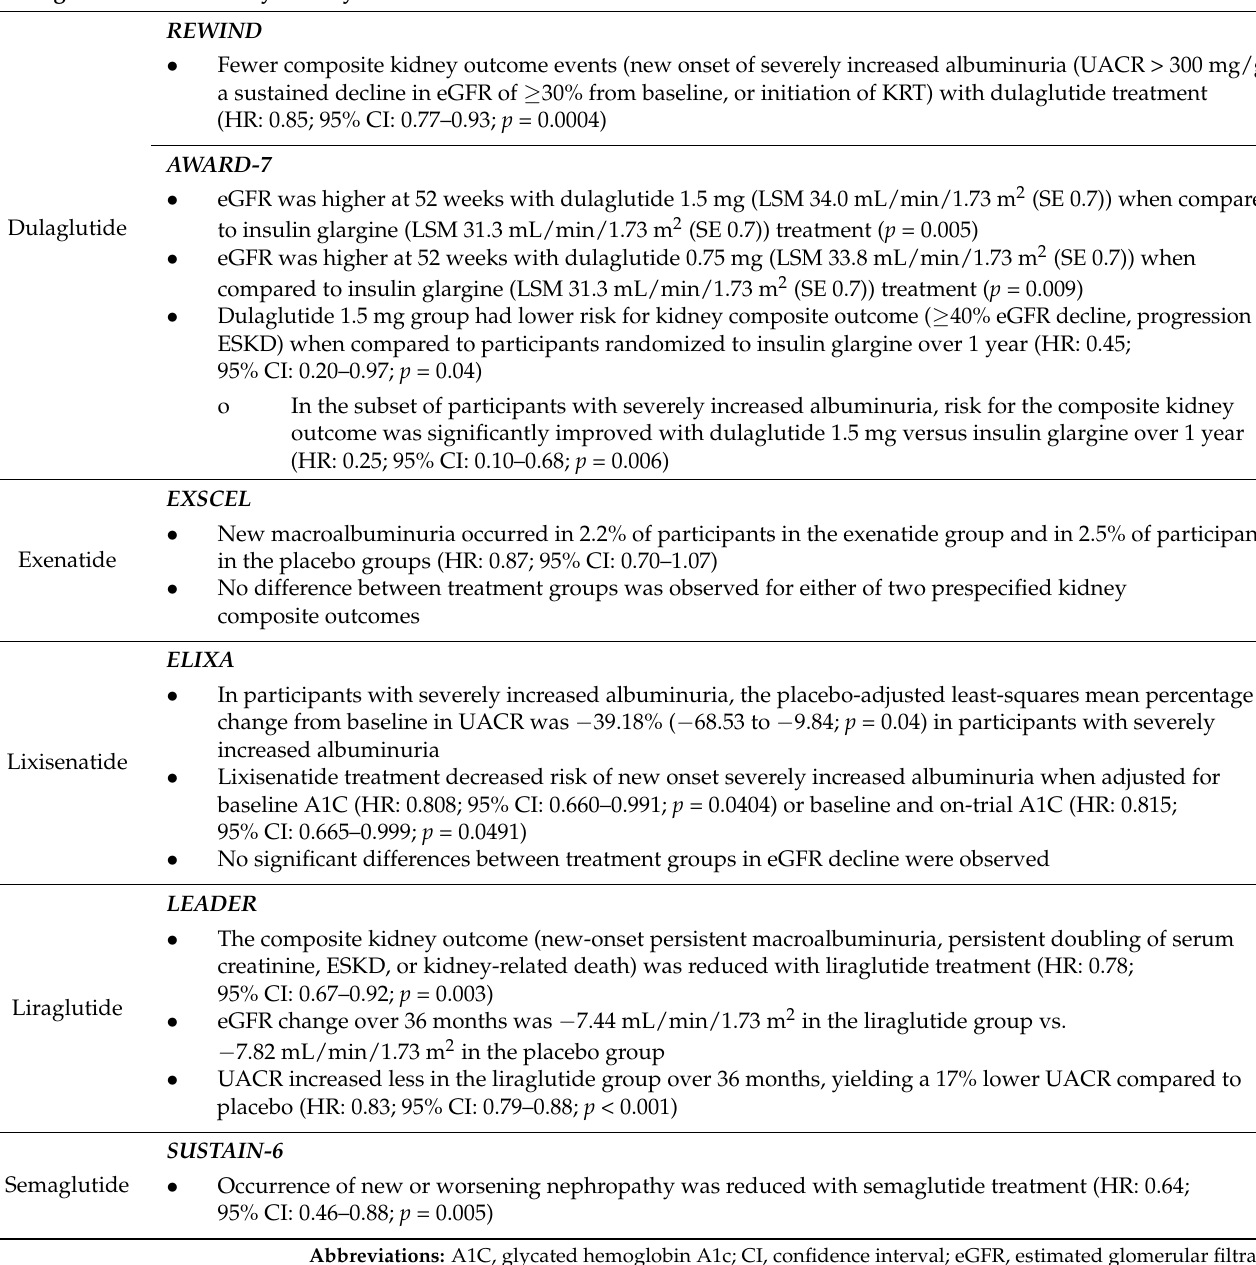
Table 2. Select Kidney Outcomes from GLP-1 Receptor Agonist Clinical Trials [49,53,55,58–61]. Agent Secondary Kidney